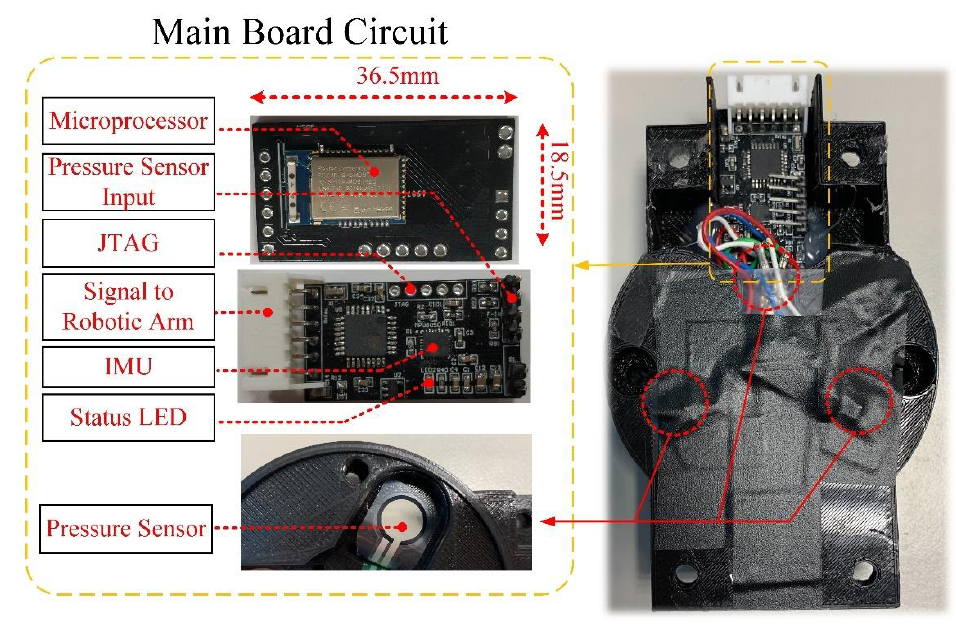
Figure 5. Stereogram of the hardware